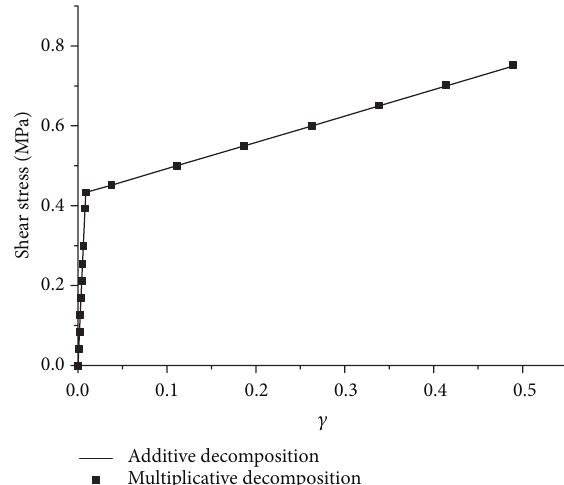
Figure 7: Shear stresses under shear loads for different decomposi- tions of plastic